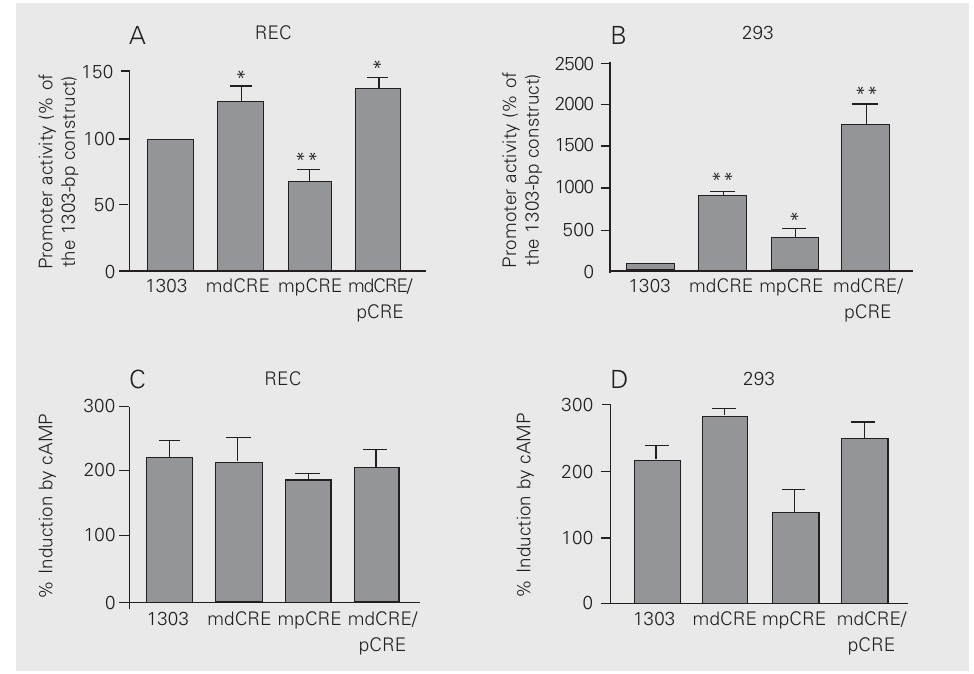
Figure 5. Role of the cAMP-responsive elements dCRE and pCRE in basal and cAMP-induced transcription in endothelial and renal cells. A , Basal transcription in endothelial cells. The wild type 1303-bp promoter and mutants harboring Bgl-II restriction sites in place of dCRE (mdCRE), pCRE (mpCRE) and in both CRE-like sequences (mdCRE/pCRE) were transfected in rabbit endothelial cell (REC). Cells were harvested 24 h after transfection. Luciferase activity in cell extracts was normalized to beta galactosidase expression from a control plasmid. Promoter activity is the ratio of luciferase/beta galactoside expression and is reported as percent of the activity in the 1303-bp angiotensin converting enzyme (ACE) promoter. Data are reported as the mean ± SEM for 5 independent experiments (N = 6 in each). B , Basal transcription in renal cells: 293 cells were transfected with the same promoter constructs as in A and results were analyzed and reported as described for panel A . C , cAMP- induced transcription in endothelial cells. The wild type 1303-bp ACE promoter and the mutants harboring substitutions in CRE-like sequences were transfected in an endothelial cell line (REC) to identify promoter sequences involved in the response to cAMP. After 24 h of transfection, cells were serum-starved for 16-24 h on F12 supplemented with 0.5% FBS and then stimulated with 5 mM 8BrcAMP for 4 h. Data are reported as percent induction compared to control values for each construct. Data are reported as the mean ± SEM for 4 independent experiments (N = 6 in each). D , cAMP-induced transcription in renal cells. 293 cells were transfected with the same promoter constructs as in C and results were analyzed and reported as in panel A . *P < 0.05; **P < 0.01 compared to the 1303-bp ACE promoter (one-way analysis of variance and post hoc Tukey